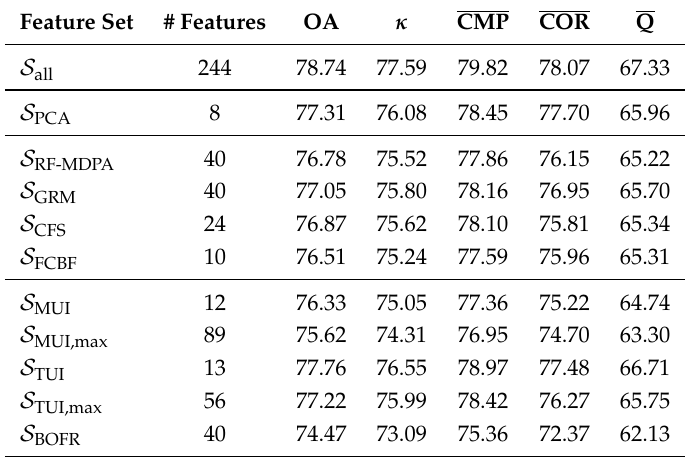
Table 5. Classification results (in %) derived with the Random Forest (RF) classifier for the EnMAP dataset (20